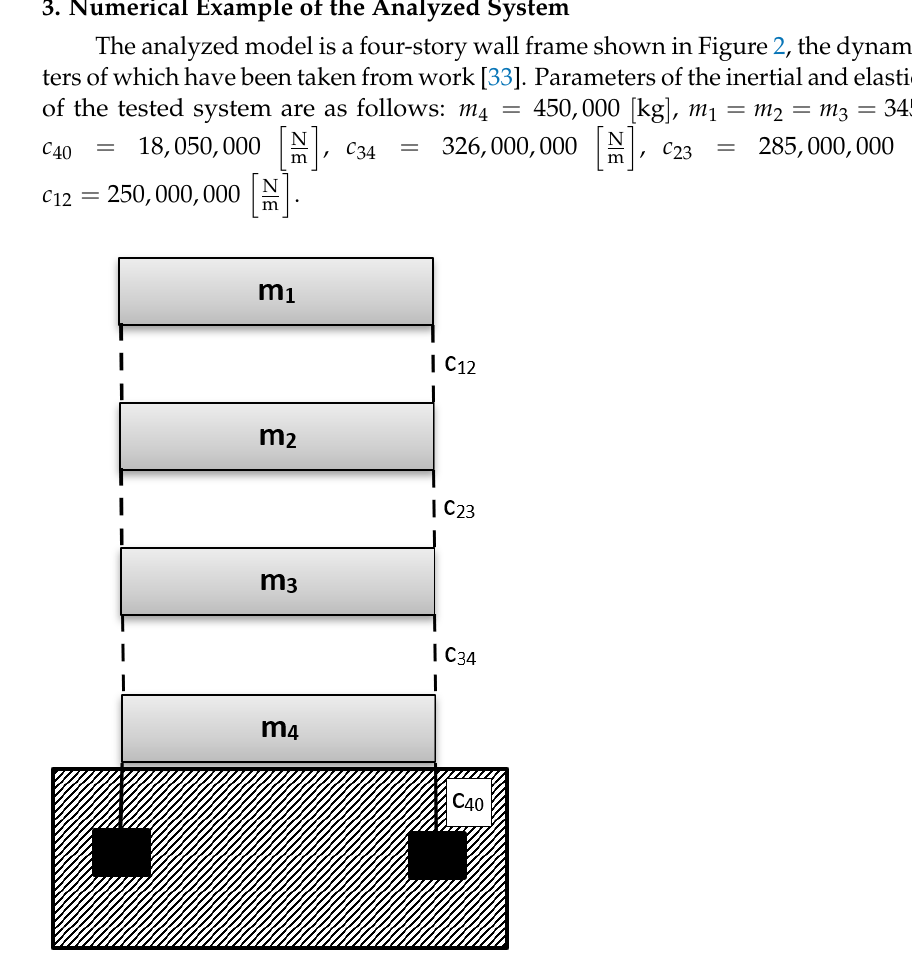
Figure 2. Model of the tested system.